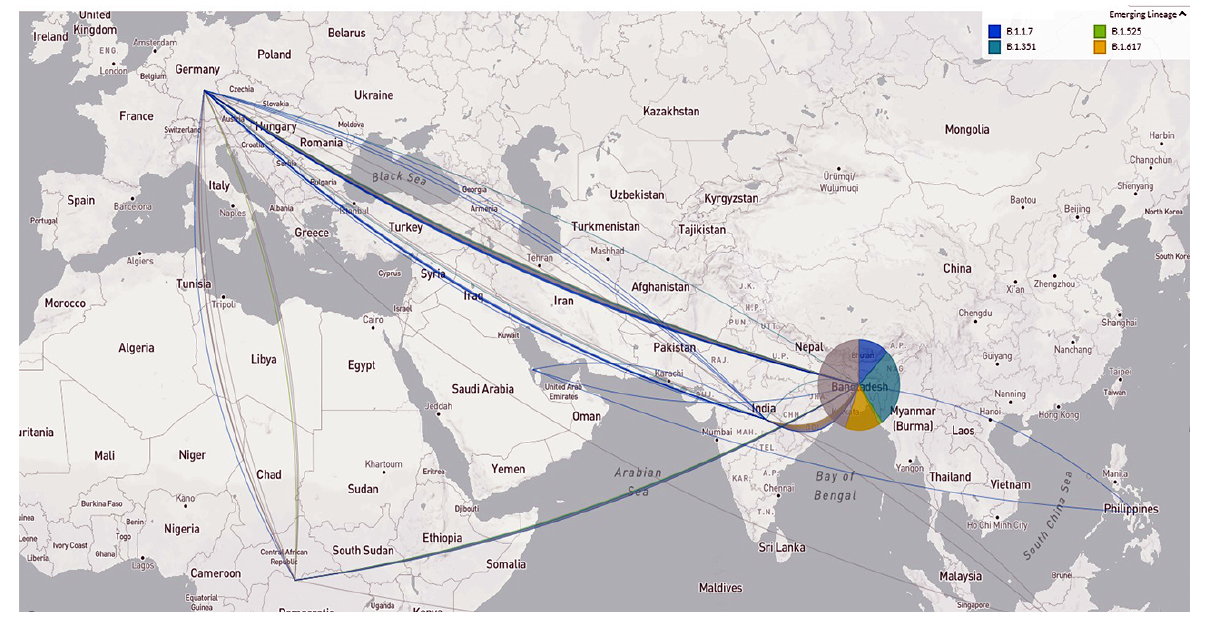
Figure 6. Emerging variant’s geographic transmission lines to Bangladesh (live display at nextstrain.org/ncov, accessed on 15 September